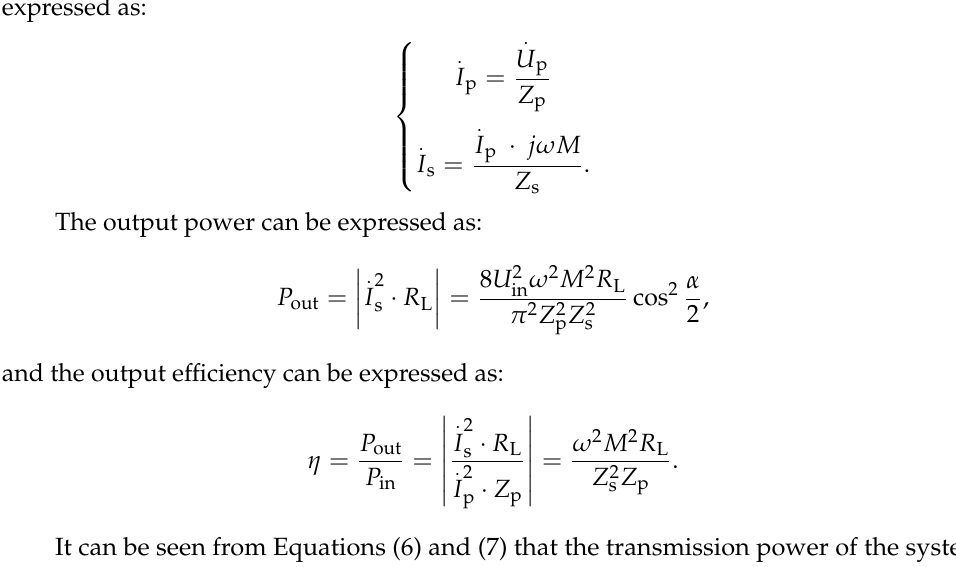
35 Ω Figure 5. Voltage, power and phase diagram. Considering the voltage fluctuation problem, the voltage variation range is selected as 5%, and the corresponding α is 0 – 36.5°. Using DSP to generate PWM waves with dif- ferent phases, 8ASK, 16ASK or higher MASK information modulation is performed to increase the signal bit width, thereby increasing the signal transmission rate. In the speci- fied α range, according to Figure 5, the appropriate signal bit width, phase angle and cor- responding voltage change value are selected. This can ensure the rate while reducing the bit error rate as much as possible. Table 2 shows the modulation parameters of 8-ary and 16-ary signal.